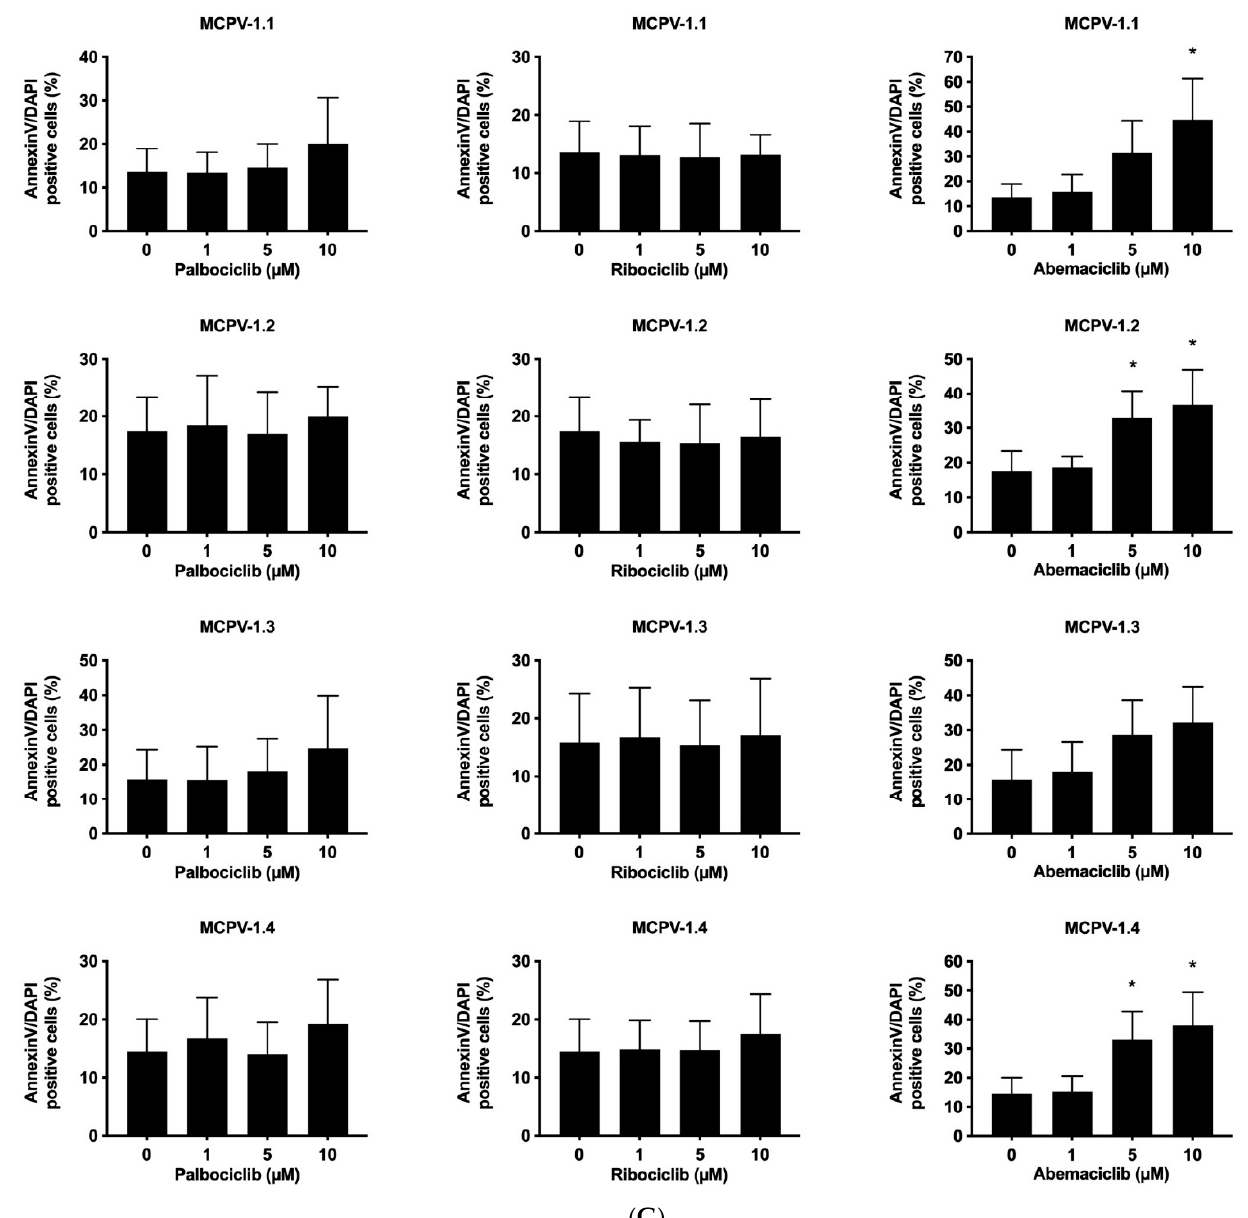
Figure 2. CDK4/CDK6 inhibitors counteract proliferation and survival of neoplastic mast cells (MCs) and induce cell cycle arrest by inhibiting phosphorylation of RB1. A–B: HMC-1 ( A ) and ROSA ( B ) cells were incubated in control medium (Co) or in medium containing 1 µM of palbociclib (Palbo), ribociclib (Ribo) or abemaciclib (Abema), as indicated, at 37 °C for 4 h. Thereafter, cells were harvested and western blotting was performed, as described in the text, using antibodies against phosphorylated RB1 (pRB1), total RB1, and actin. ( C ) HMC-1 and ROSA cells were kept in control medium (Co) or were incubated with different concentrations of palbociclib (Palbo), ribociclib (Ribo), or abemaciclib (Abema), as indicated, for 48 h. Thereafter, PI was added and cell cycle distribution was determined by flow cytometry. The percentage of cells in G1-phase, G2/M-phase, and S-phase in each condition are shown. To determine statistical significance, ANOVA and post-testing by Dunnett test were performed. Asterisk (*): p < 0.05. ( D , E ) HMC-1 and ROSA ( D ), as well as MCPV-1 cells ( E ), were incubated in control medium (0 nM) or medium containing various concentrations of palbociclib, ribociclib, or abemaciclib, as indicated, at 37 °C for 48 h. Thereafter, 3 H-thymidine uptake was measured. Results are expressed as percentage of control and represent the mean ± S.D. from three independent experiments. Statistical significance was reached in all experiments, as analyzed by ANOVA and post-testing by Dunnett test (Supplementary Materials, Table S6). ( F , G ) HMC-1 and ROSA cells ( F ), as well as MCPV-1 cells ( G ), were incubated in control